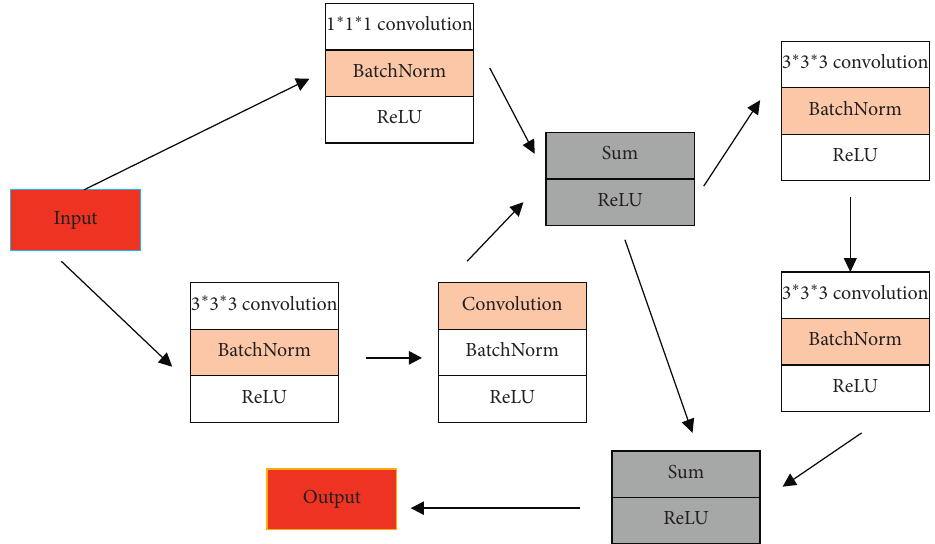
Figure 6: Experience pool theory.